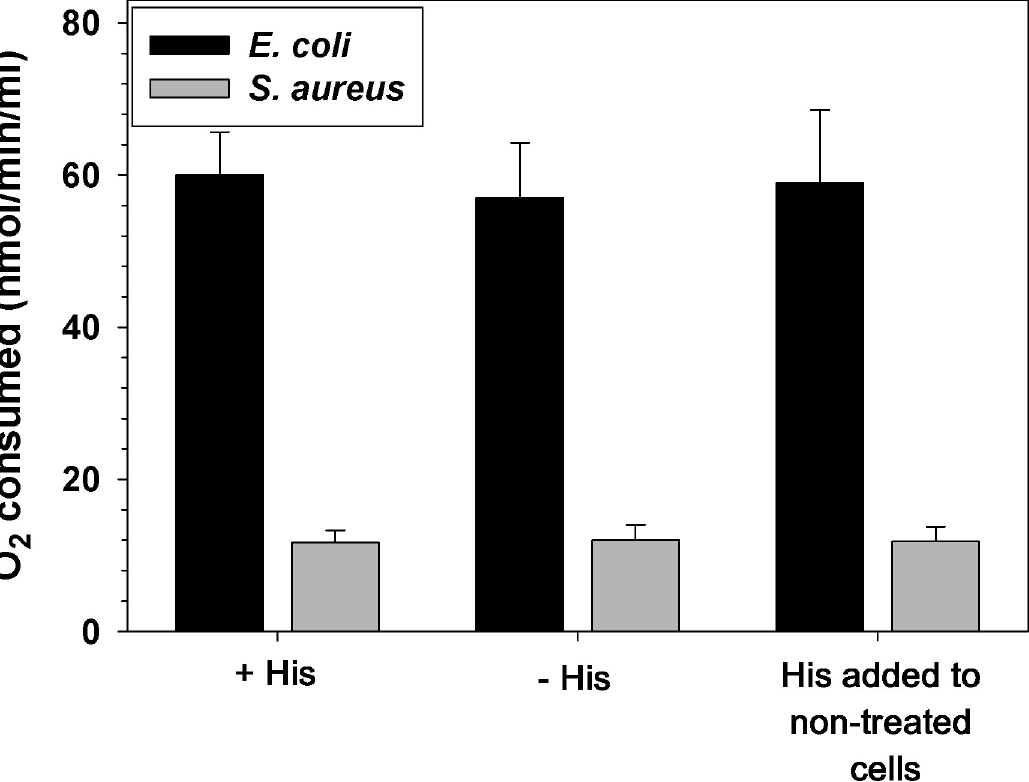
Fig 6. Effect of histidine on respiration. E . coli and S . aureus were grown to mid-log phase with 5.0 mM histidine (His) or without histidine. The cells were washed and resuspended to OD = 0.5 in PBS/glucose. Half ml of cell suspension was added to 2.5 ml of PBS glucose in a thermostatic chamber fitted with a Clark electrode. In separate runs, histidine was added to non-treated cell suspensions to a final concentration of 5.0 mM (the third set of bars). The experiment was repeated twice in triplicates. Mean ± SD is